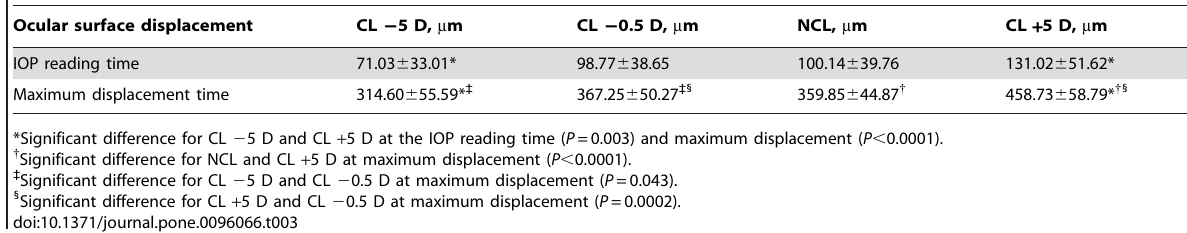
Ocular surface displacement